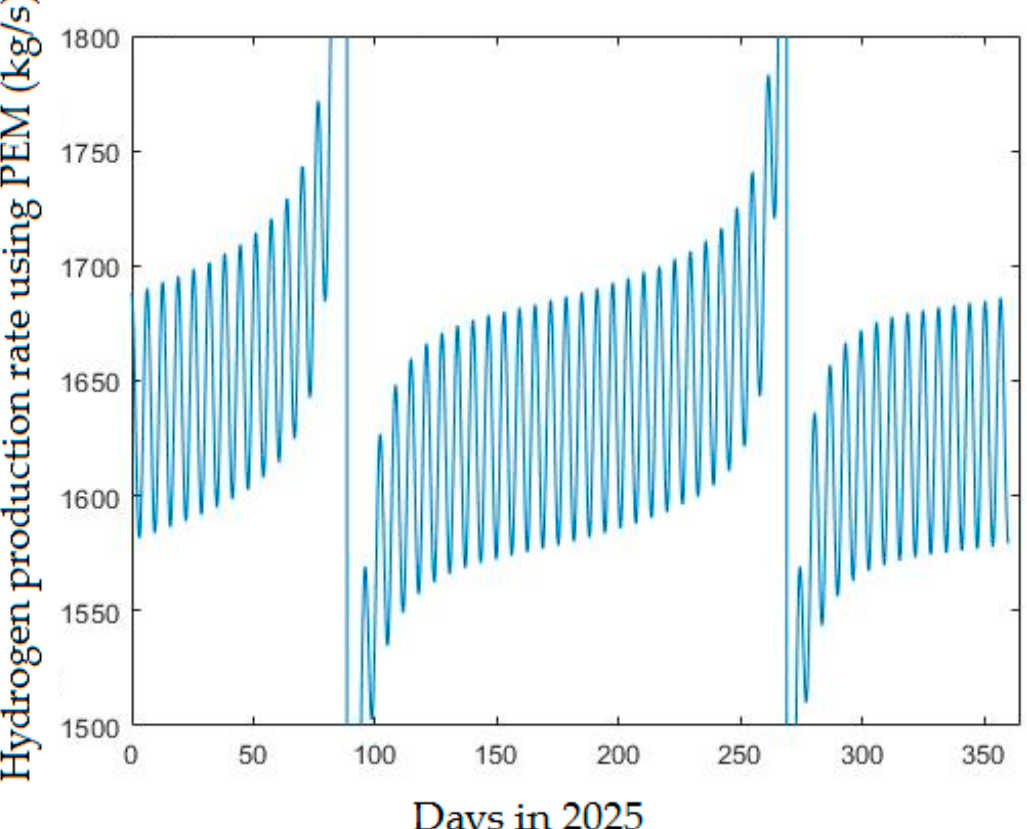
Figure 10. Hydrogen production rate applying PEM throughout 2025.